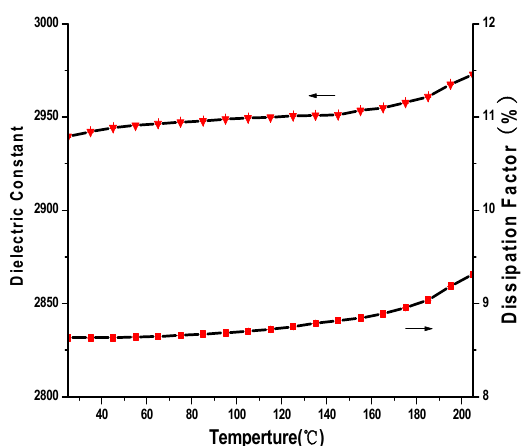
Figure 11. Temperature dependence of dielectric constant and dissipation factor of the BTO thin film at 1 kHz.